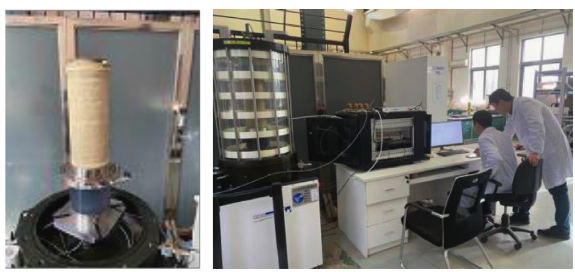
Figure 3: Hierarchical loading method.